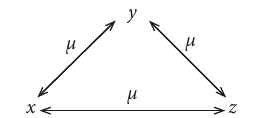
Figure 1: The global mutation in